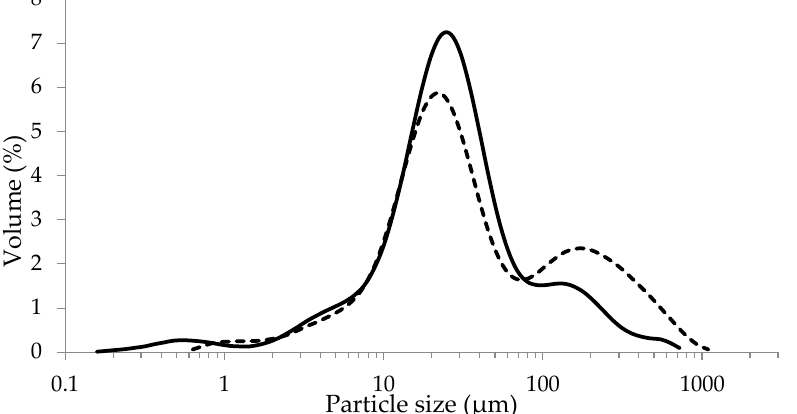
Figure 1. Particle size distribution of yellow pea flours milled with mesh sizes of 0.75 mm (solid curve) and 2.0 mm (dashed curve).